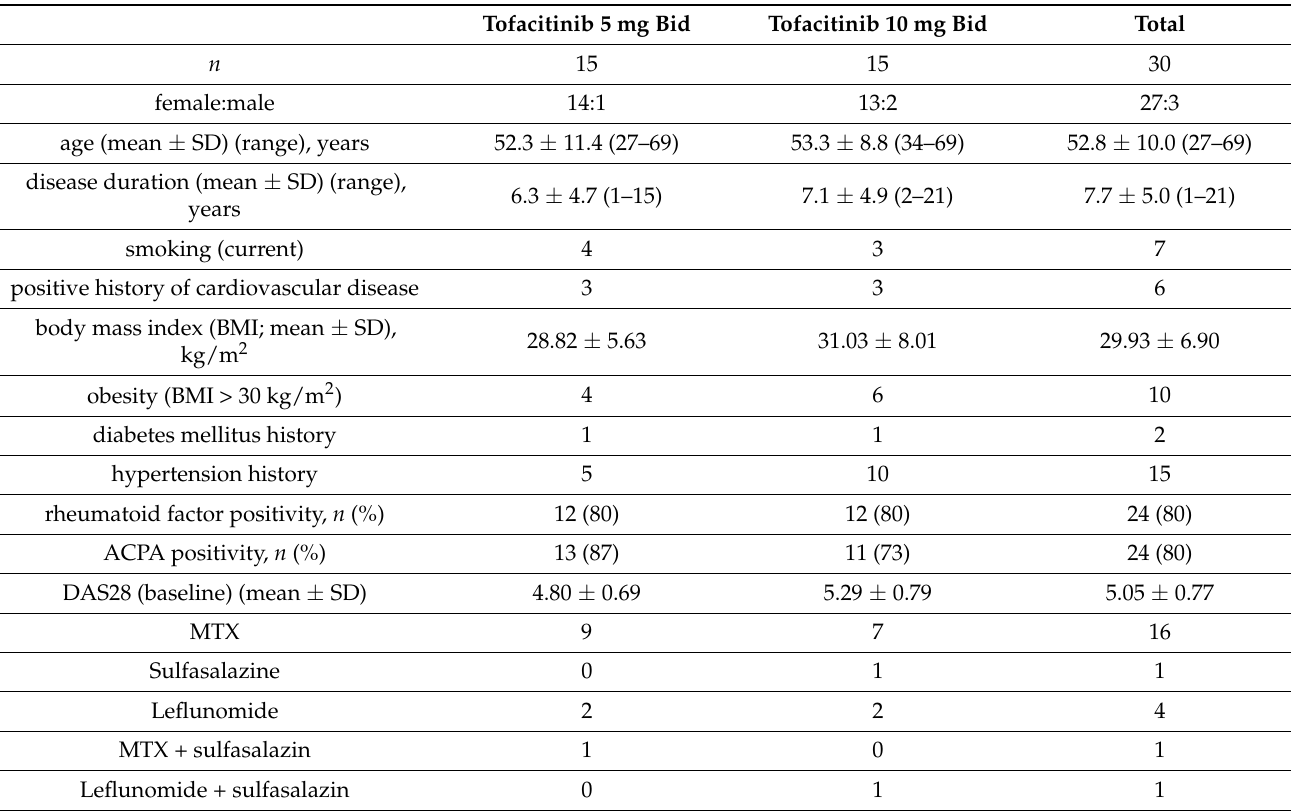
Table 1. Patient